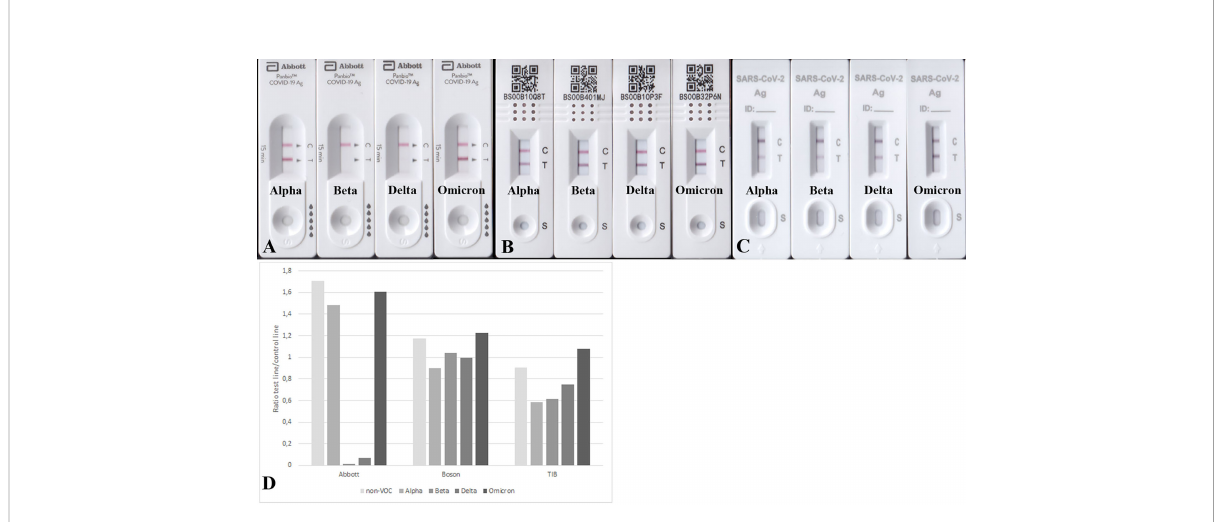
FIGURE 3 RATs detecting 100 ng N protein of Alpha, Beta, Delta, and Omicron. RATs were from different companies: Abbott (A) , Boson (B) , and TIB (C) . (D) Densitometric analysis of RATs shown in (A-C) . Corresponding RATs loaded with non-VOC strain are shown in Figure 2A.